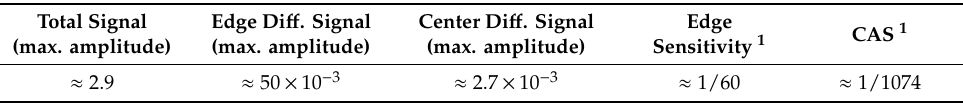
Table 4. Main results from the calculated signals, shown in Figure 9.